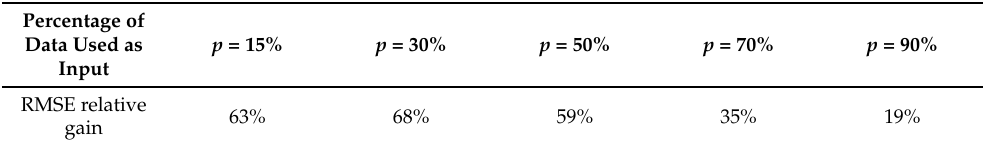
Table 8. Average gain in RMSE when calibrating the SABR model with the output of the GP regression model.